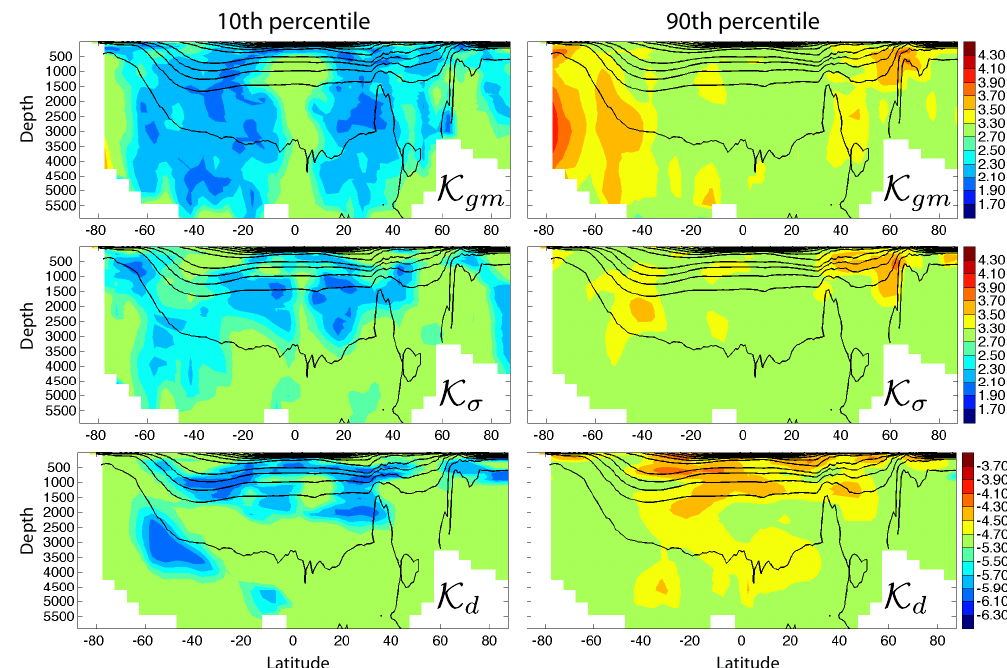
Figure 2. Estimated bolus velocity coefficient (top; K gm ), isopycnal diffusivity (middle; K σ ) and diapycnal diffusivity (bottom; K d ) in square meters per second (log 10 color scale). Left: 10th percentile at each latitude and depth; right: 90th percentile. Overlaid black contours denote the time mean zonal mean potential density from the OCCA atlas (Forget,